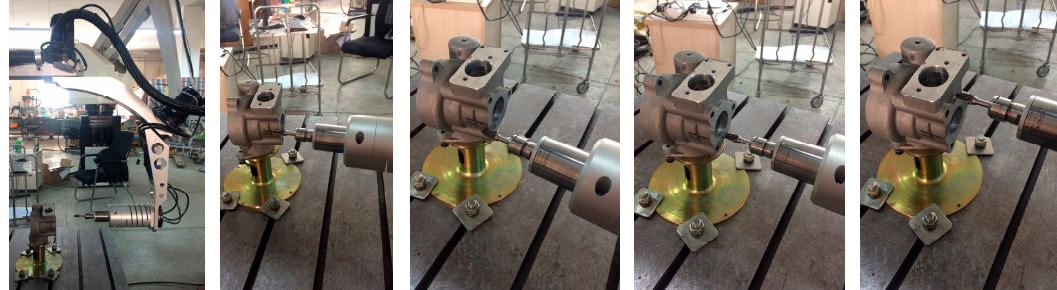
Figure 25. Experimental deburring of facet edges on distal side facet. Appl. Sci. 2019 , 9 , x FOR PEER REVIEW